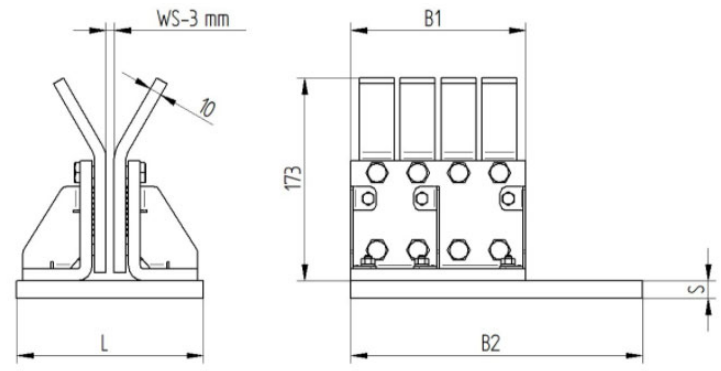
Figure 2. Diagram with dimensions for direct contact [29].